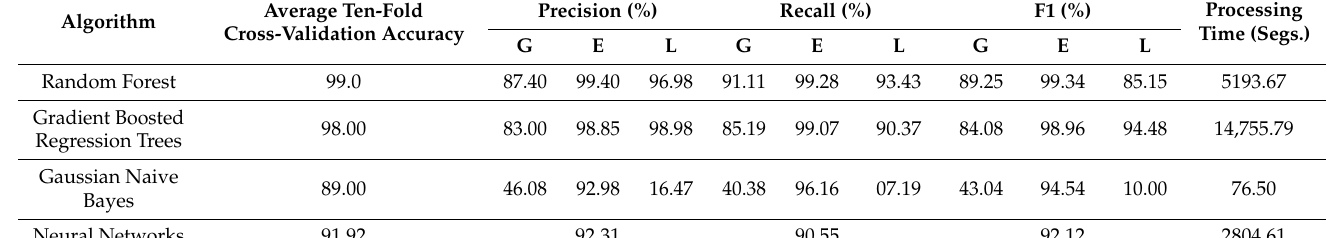
Table 4. Performance results for the dataset obtained in step 1.